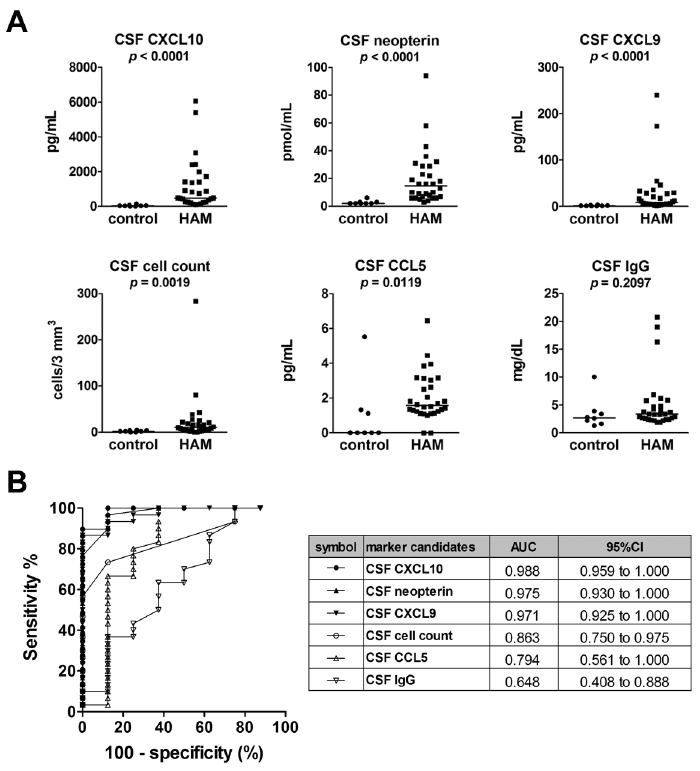
Figure 2. Selection of candidate biomarkers in the cerebrospinal fluid (CSF) by comparing HAM/TSP patients and control subjects. ( A ) CSF levels of total protein, cell count, IgG, neopterin, sIL-2R, and nine chemokines (CCL3, CCL4, CCL5, CXCL9, CXCL10, CXC11, CCL17, CCL20, and CCL22) were measured and compared between HAM/TSP patients (HAM; n=30) and HTLV-1-infected control subjects (control; n=eight: seven ACs and one ATL patient). Data is shown for the top six CSF markers ranked according to the significance of the difference between the HAM/TSP patients and the control subjects. Horizontal bars indicate the median values. The Mann-Whitney U -test was used for statistical analysis. ( B ) ROC analysis was employed to assess the sensitivities and specificities of the six markers exhibited in part (A) for discriminating HAM/TSP patients from controls. AUC=area under the ROC curve; 95% CI=95% confidence interval.